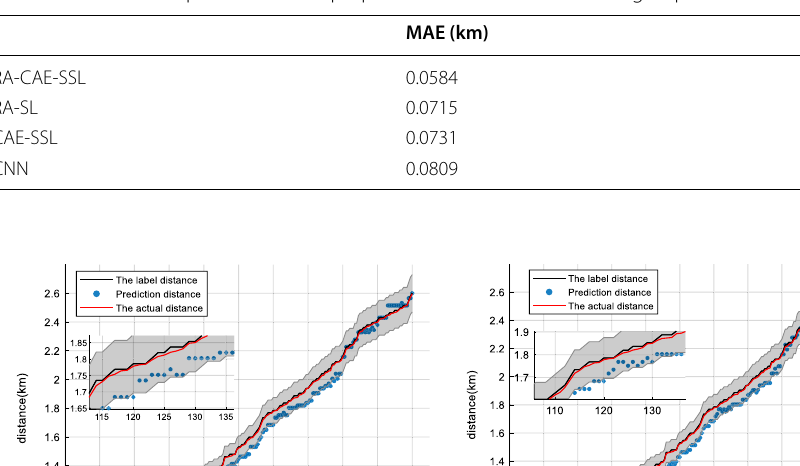
Table 5 Localization performance of proposed framework and control groups